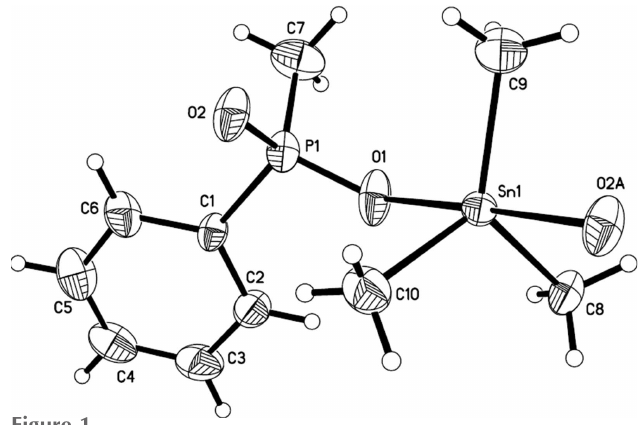
Figure 1 The asymmetric unit of the title compound, showing 30% probability displacement ellipsoids.